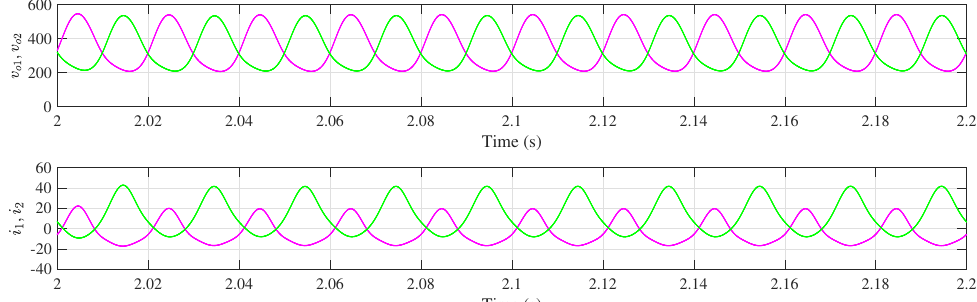
Figure 3. The sampled inductor currents i 1 ( nT ) and i 2 ( nT ) and capacitor voltages v o 1 ( nT ) and v o 2 ( nT ) for S = 1000 W/m 2 in steady-state operation. V M = 3.2 V.